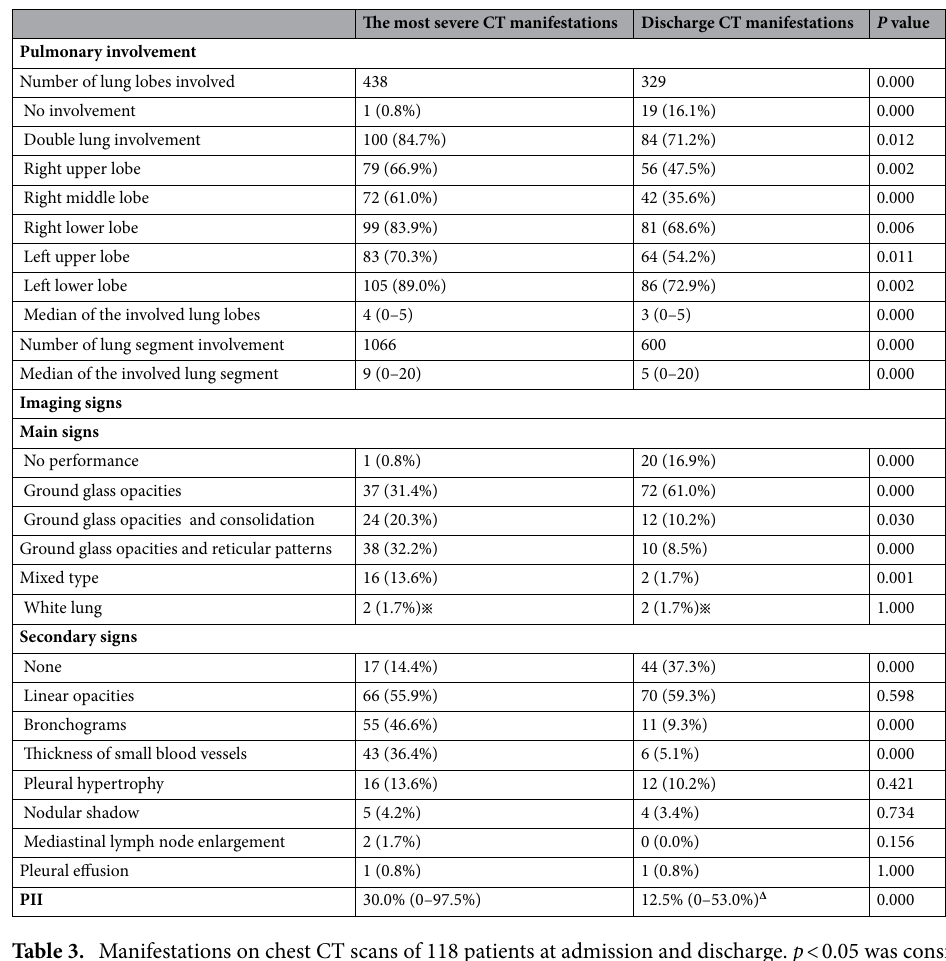
Table 3. Manifestations on chest CT scans of 118 patients at admission and discharge. p < 0.05 was considered statistically significant. Two patients showed severe white lung disease. After treatment, there was no improvement, and the symptoms remained. The two patients eventually died. Δ Statistics exclude two deaths. ※